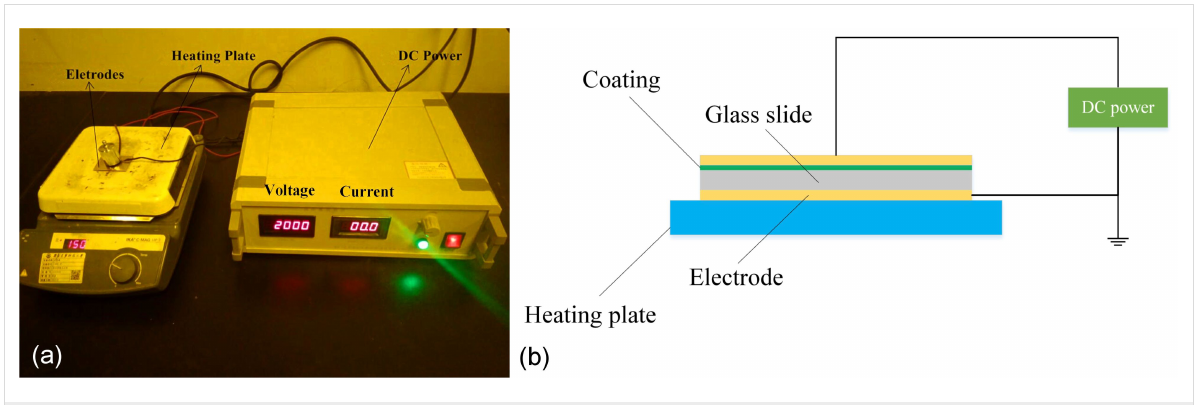
Figure 1: Images of the experimental device for